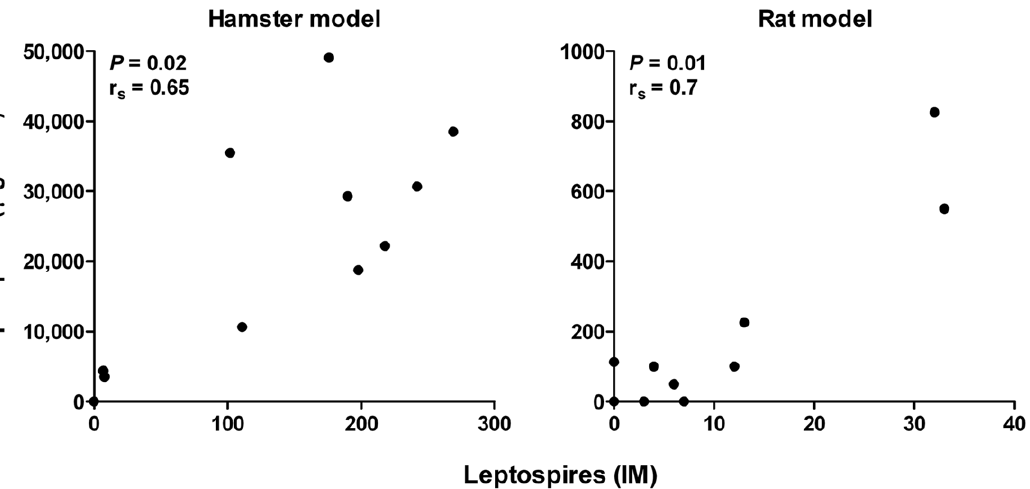
Figure 2. Correlation between the quantification of leptospires by qPCR and the IM. A significant ( P , 0.05), positive correlation was observed between the qPCR and the IM techniques in the experimental models of leptospirosis (rat and hamster) used in this study. The leptospiral loads for the qPCR are displayed as leptospires per m g DNA and in the IM as leptospires per 10 fields-of-view ( 6 1000 magnification).